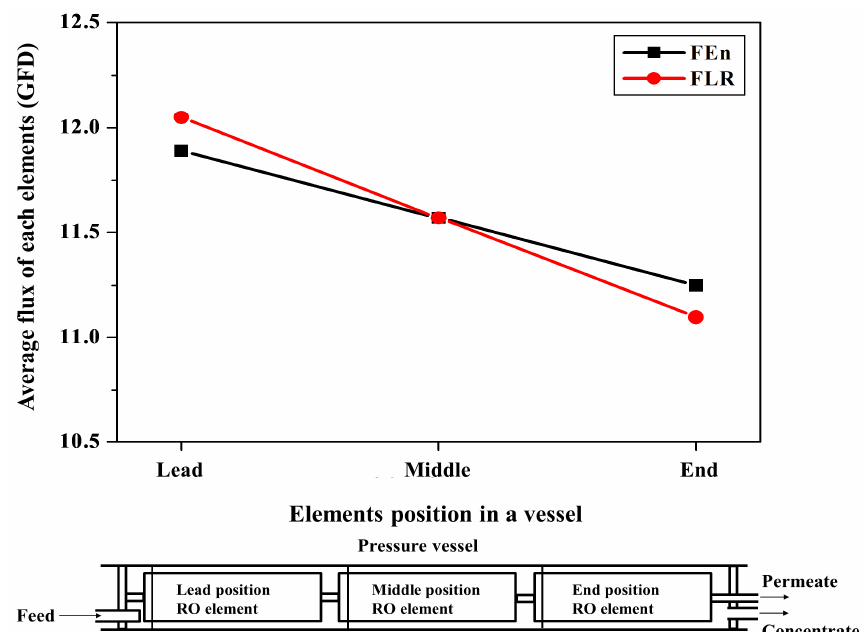
Figure 9. Predicted average flux of the individual elements from the simulation study according to the located position in a vessel and permeate flow rate of RO elements.